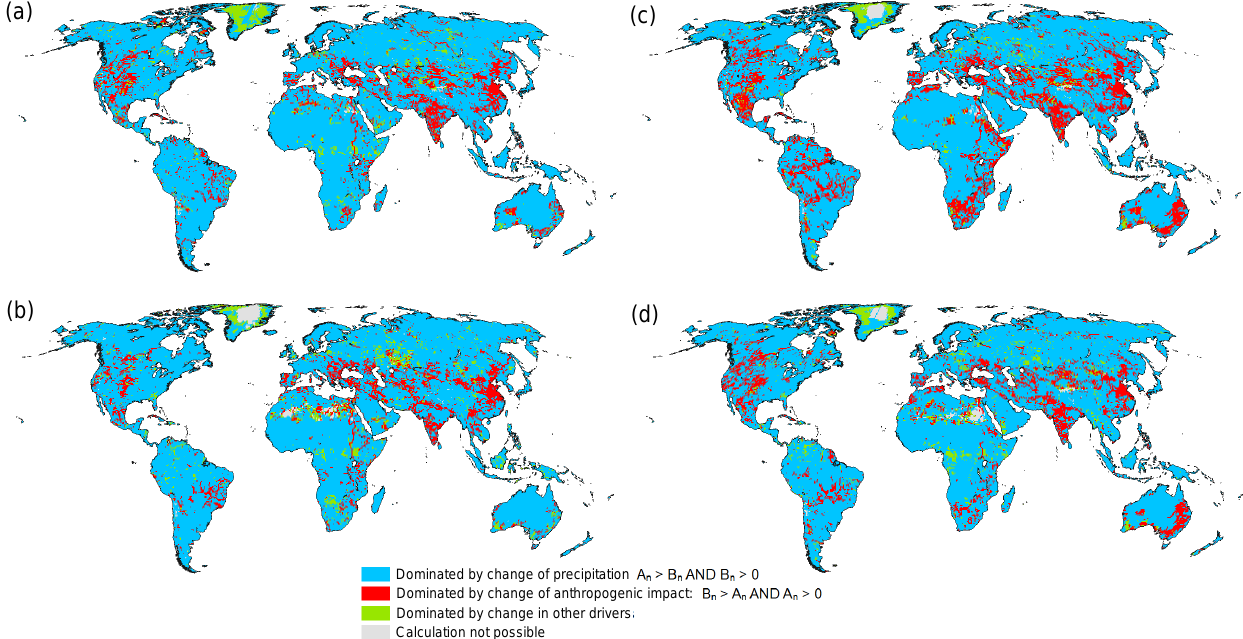
Figure 4. Relative dominance of drivers of change of long-term average Q between 1941–1970 and 1971–2000 (Sect. 2.4.2). Blue indicates that change in P is more dominant than change in anthropogenic impact due to water abstraction and dam construction, red indicates the opposite. In green areas, other drivers are dominant. In grey areas, a calculation is not possible as the denominator of indicators A n and B n is zero (no change in long-term average Q ). Results are shown for WaterGAP as driven by the meteorological forcings GSWP3 (a) , PGFv2.1 (b) , WFDEI_hom (c) , and WFD (d)